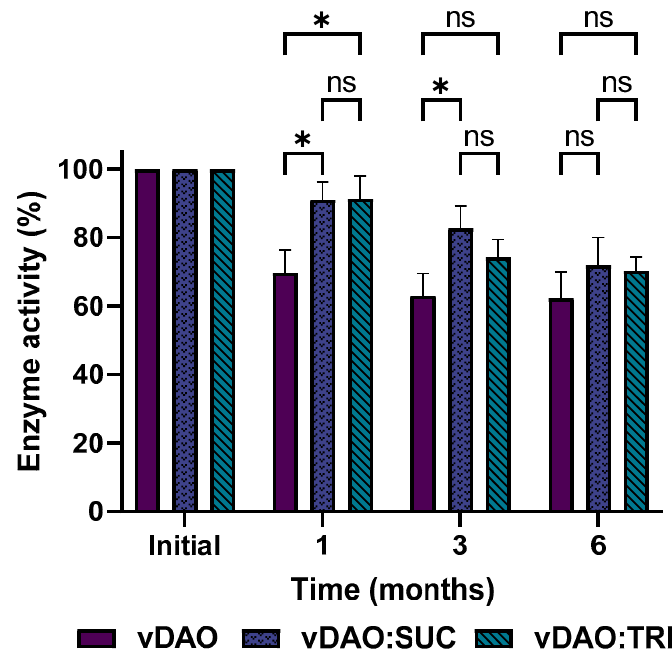
Figure 5. Enzymatic activity of vDAO in dry tablets of vDAO lyophilized powder with or without disaccharides as cryoprotectants during 6-months storage at 4 °C. vDAO activity was assayed by the DCHBS-AAP-HRP method. (Mean ± SD; n = 3; * p < 0.05 and ns: not significant; two-way ANOVA multiple comparisons.)